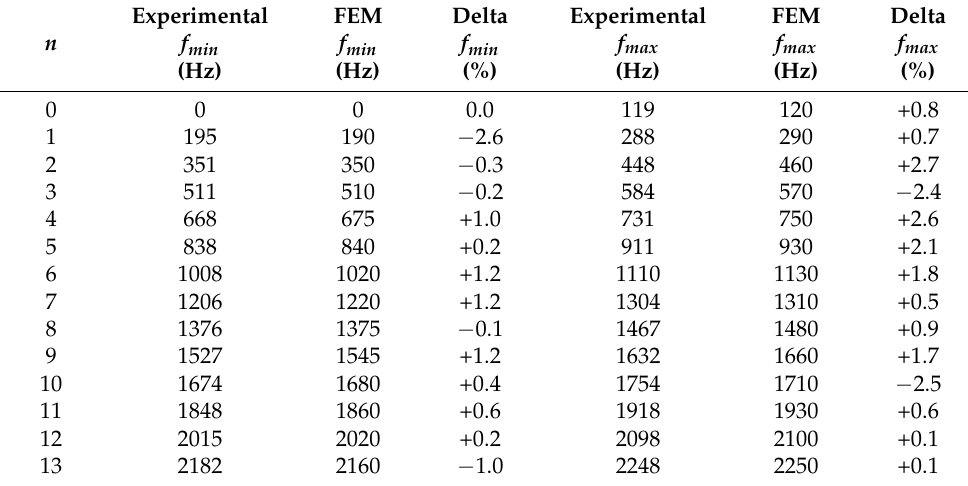
Table 7. Comparison between experimental and FEM f min and f max of TL for the model-scale scrubber with